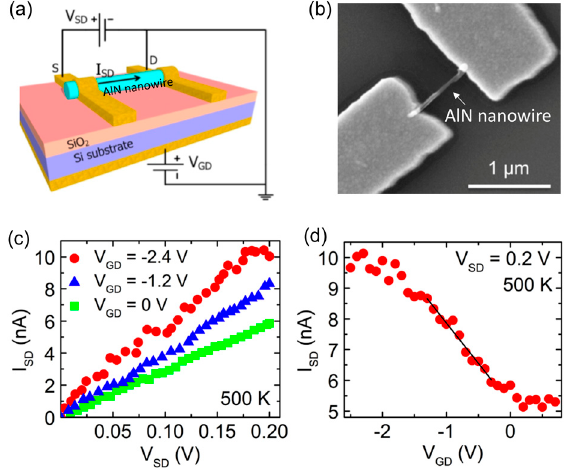
Figure 8. ( a ) Schematic of Mg-doped AlN nanowire back-gate field-effect transistor. ( b ) The corresponding SEM image. ( c ) I SD vs. V SD under different V GD measured at 500 K. ( d ) The corresponding transfer characteristics with V SD = 0.2 V. The line is a linear fit [87].